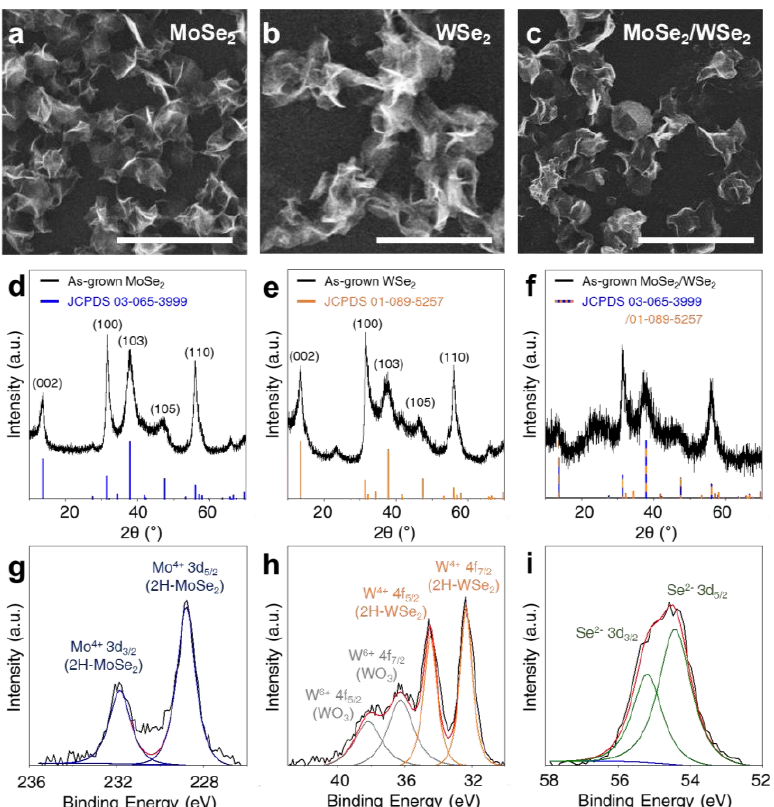
Figure 1. SEM images of the colloidally synthesized ( a ) MoSe 2 , ( b ) WSe 2 , and ( c ) MoSe 2 /WSe 2 hetero-nanosheets. Scale bars, 1 µ m. Powder XRD spectra obtained from ( d ) MoSe 2 , ( e ) WSe 2 , and ( f ) MoSe 2 /WSe 2 nanosheets, shown together with the reference peaks from the corresponding JCPDS library (MoSe 2 : JCPDS 03-065-3999 and WSe 2 : JCPDS 01-089-5257). Core-level XPS spectra of ( g ) Mo 3d, ( h ) W 4f, and ( i ) Se 3d of MoSe 2 /WSe 2